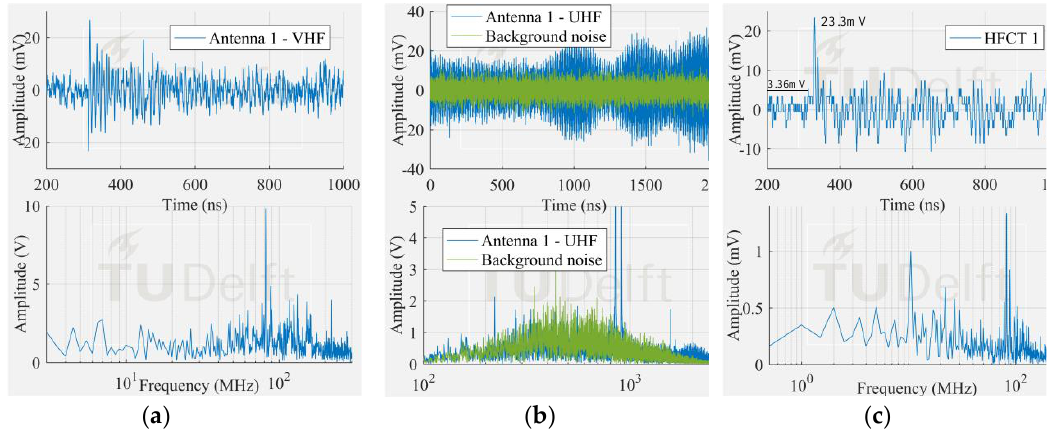
Figure 10. Smallest corona signal measured by ( a ) antenna 1 in VHF; ( b ) antenna 1 in UHF; ( c ) HFCT 1.